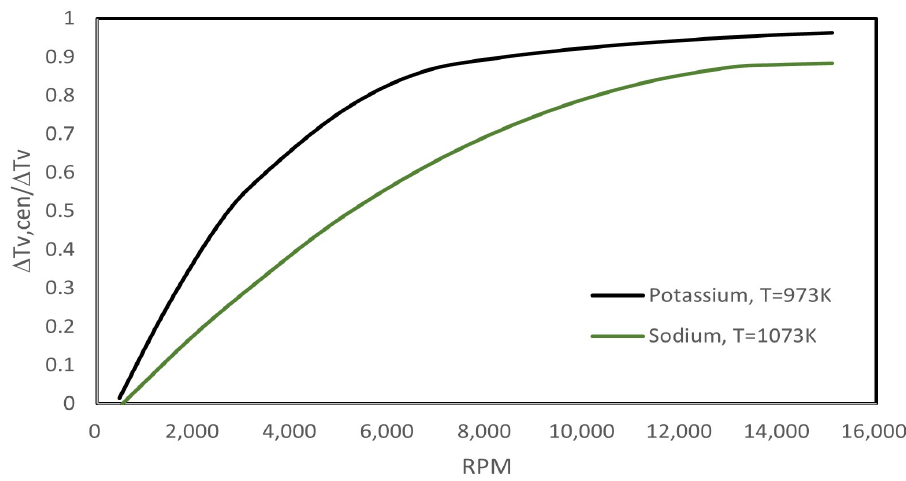
Figure 9. Dimensionless vapor temperature drop due to centrifugal acceleration as a function of rotational speed (data from [45]).